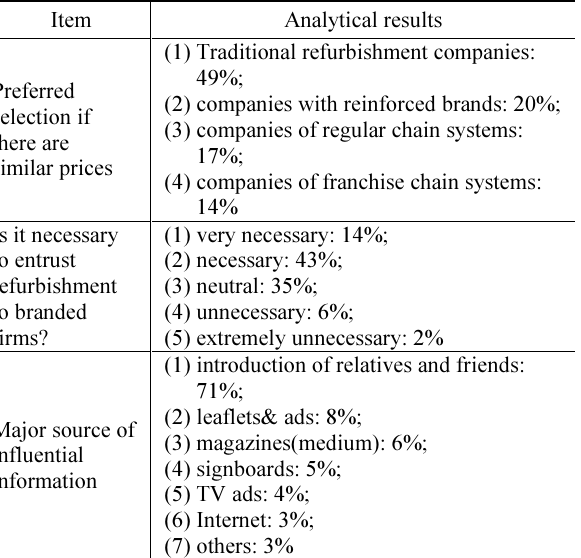
Table 1. Selection preferences of Refurbishment Customers and